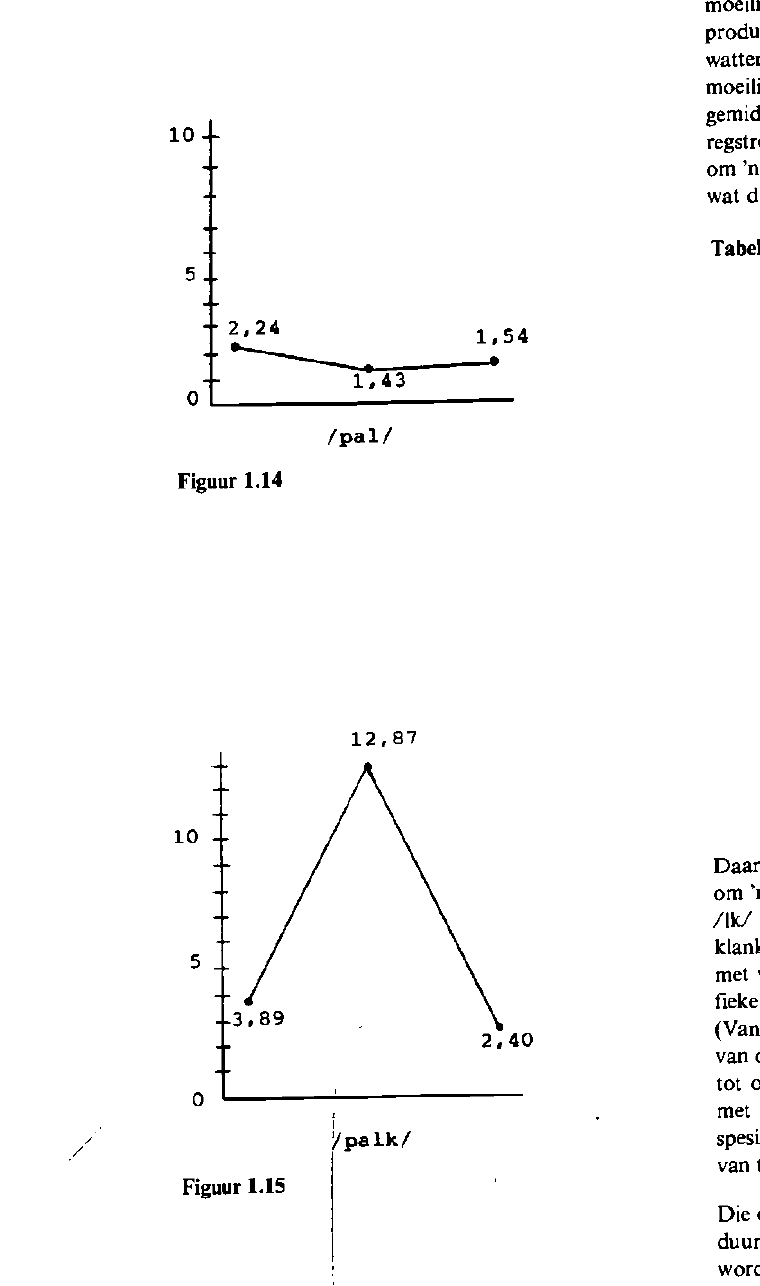
Uit bogenoemde is dit dus duidelik dat daar onkonstantheid bestaan ten opsigte van die segmentele tydsduur in die herhaalde produksie van 'n woord deur die proefpersoon met verbale apraksie. Onkonstantheid en variasie van die foutpatroon oor herhalings van dieselfde woord is een van die klinies mees waar- neembare en kenmerkende eienskappe van apraktiese spraak (Kent & Rosenbek, 1983). In teenstelling daarmee produseer die normale spreker elke herhaling met bykans dieselfde duur vir elke segment.